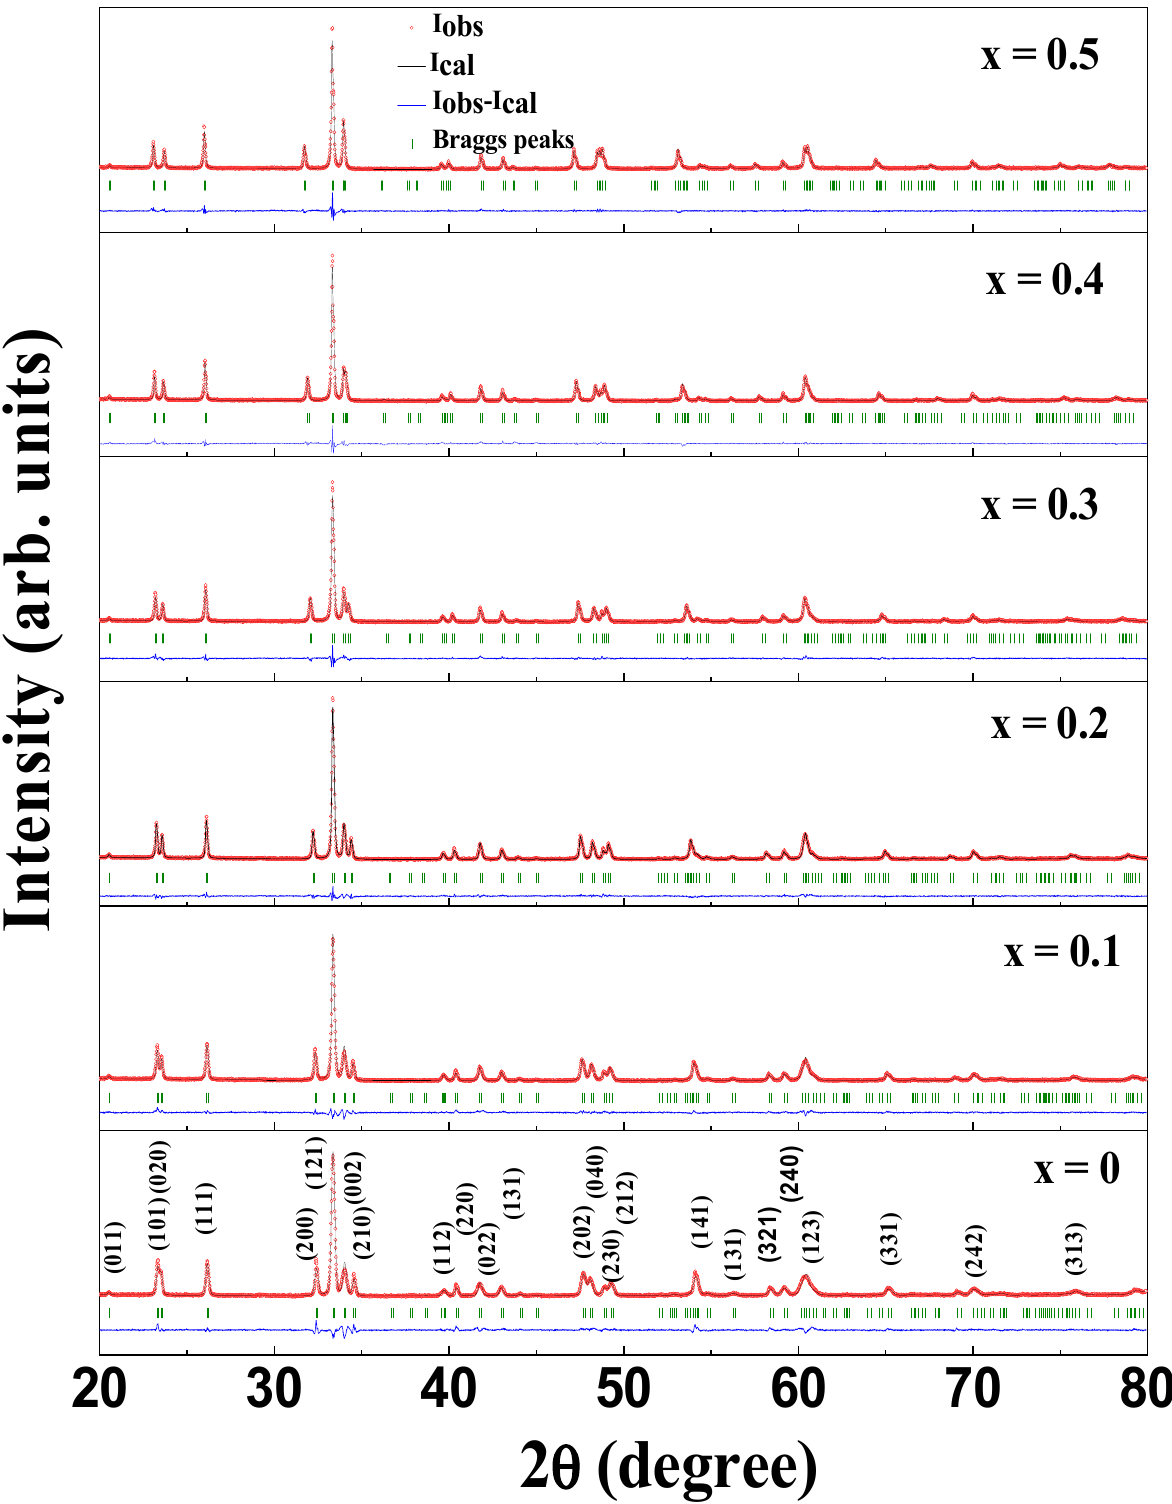
Figure 1. Rietveld-refined XRD patterns of the GECMO series.